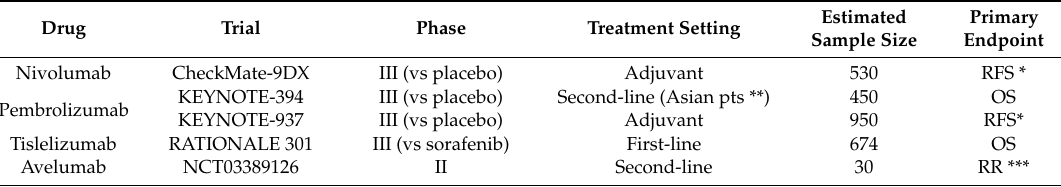
Table 2. Summary of ongoing clinical trials with anti-PD-1 and anti-PDL-1 monotherapy in HCC. Drug Trial Phase Treatment Setting